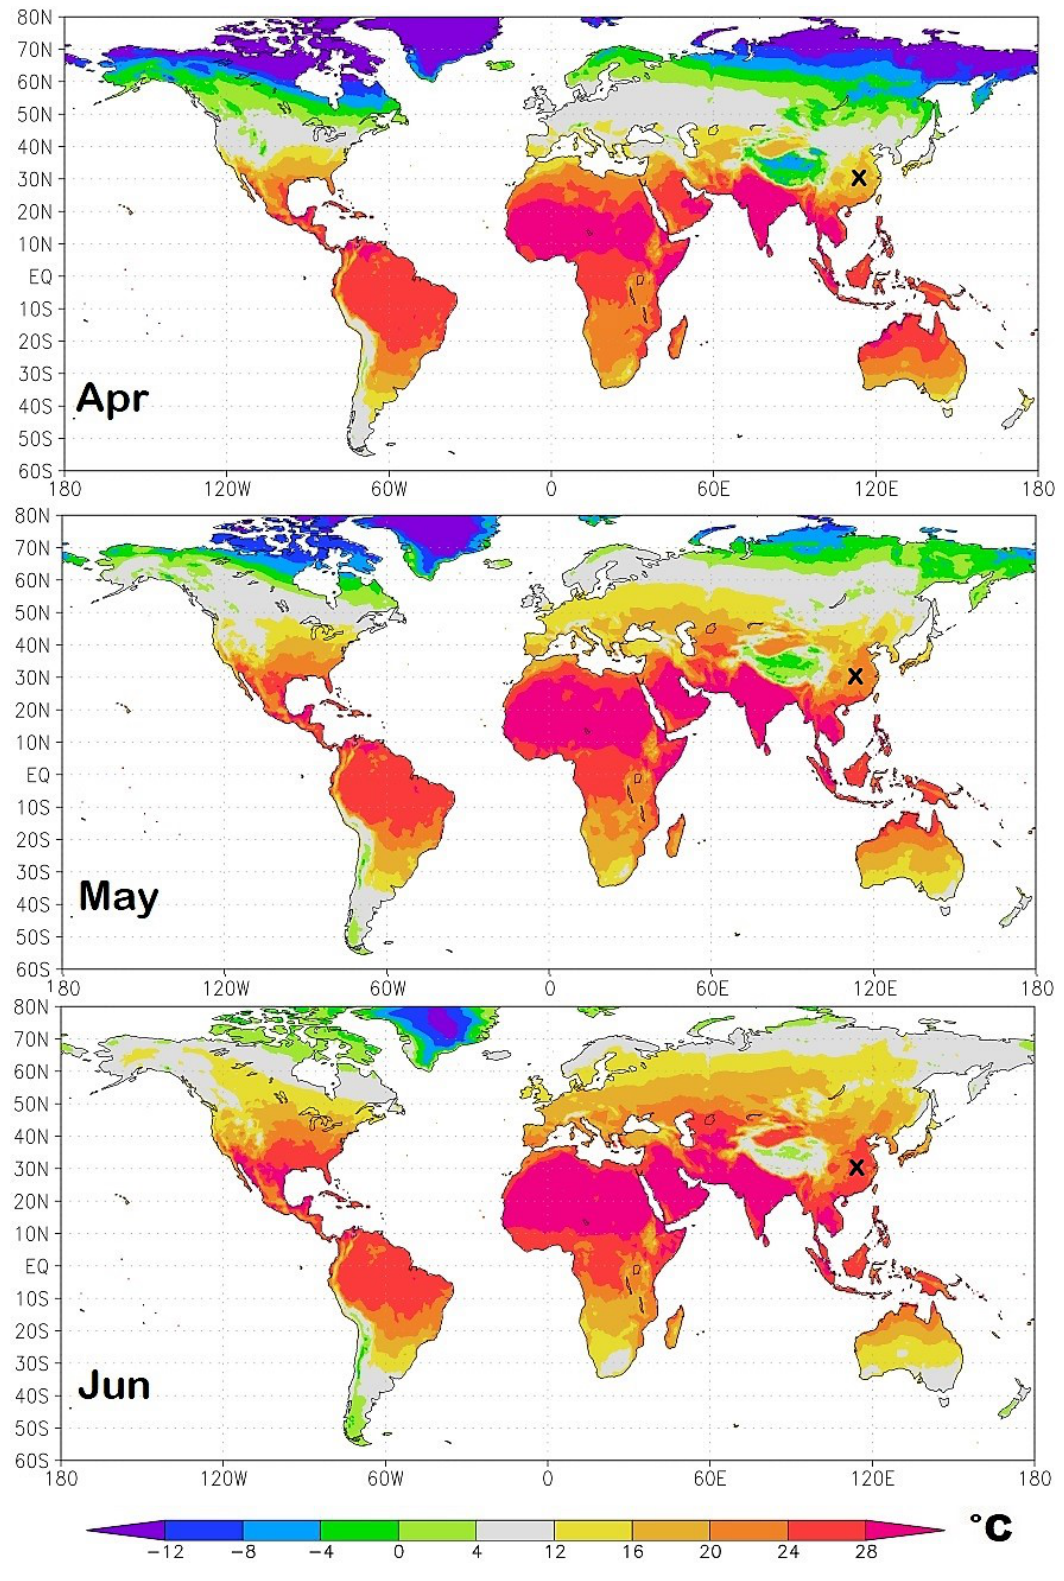
Figure 12. Spring isotherm world maps from April to June. The small x over China indicates the position of Wuhan. The light-gray zone represents the modeled most exposed regions to the COVID-19